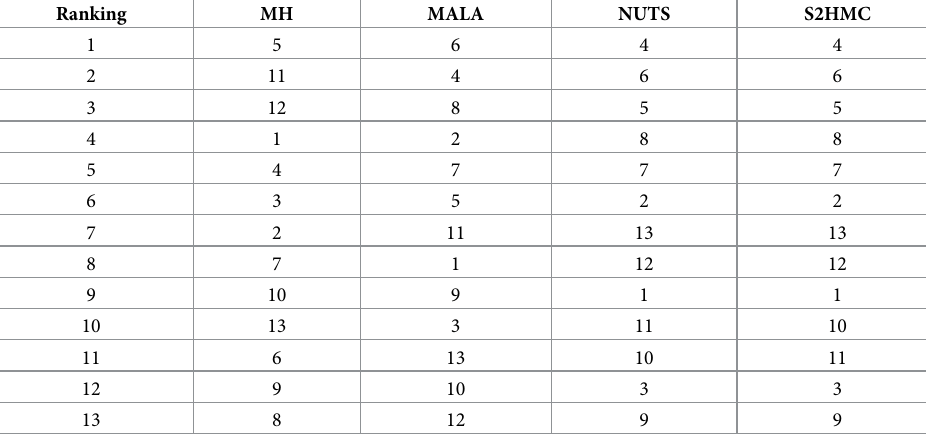
Table 4. Ranking of the financial ratios by each method. For example, NUTS ranks ratio 4 as the most important, while MH ranks ratio 12 as the third most important. Ranking MH MALA NUTS S2HMC